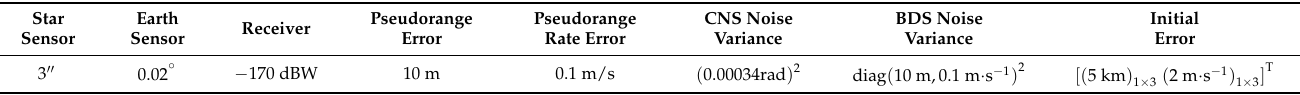
Table 3. Sensors and filters parameter